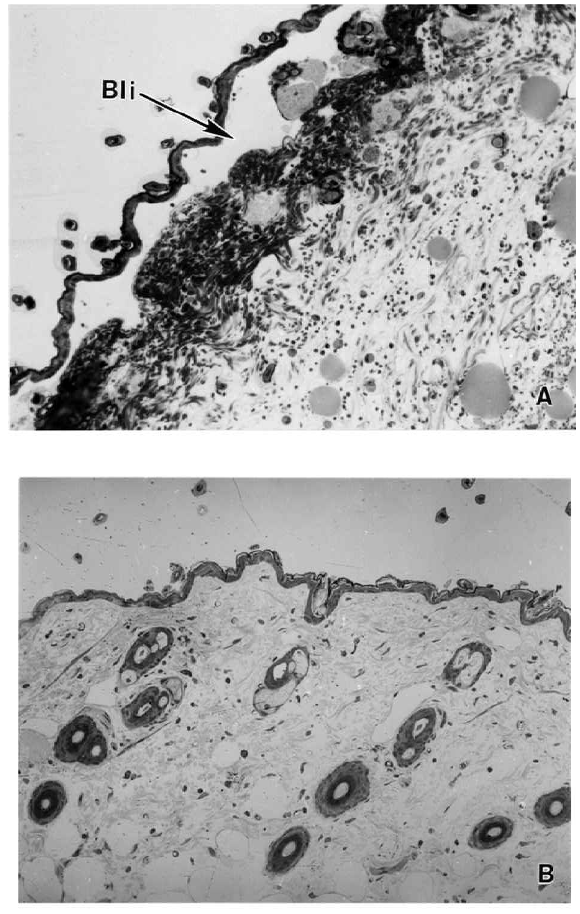
FIG. 3. Light micrographs of sections of skin from mice injected i.m. in the gastrocnemius with 60 m g of either BaP1 (A) or MT-III (B). Tissue samples were obtained 3h after injection, processed and embedded in Spurr resin. Thick (1 m m) sections were stained with toluidine blue. Notice the presence of hemorrhage in the dermis and the formation of a blister (Bli) in mice injected with BaP1, whereas no evident pathological alterations in dermis and epidermis were observed after injection of